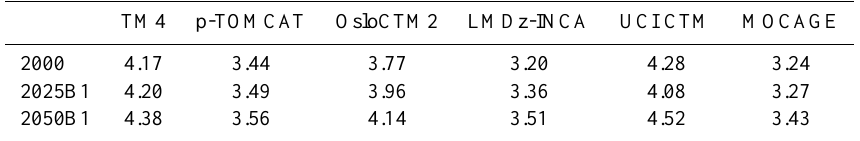
Table B2. Same as Table B1, but due to a 5% decrease in ship emissions.